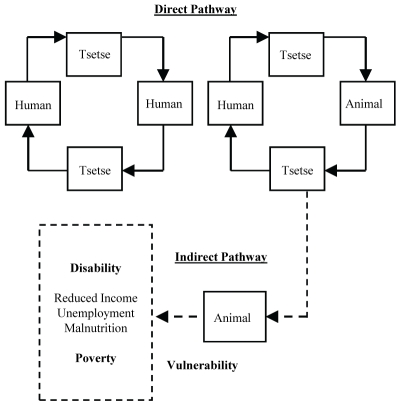
Conceptual model1 of T.b. rhodesiense sleeping sickness transmission cycle.
1Adapted from the World Health Organization, 2006.